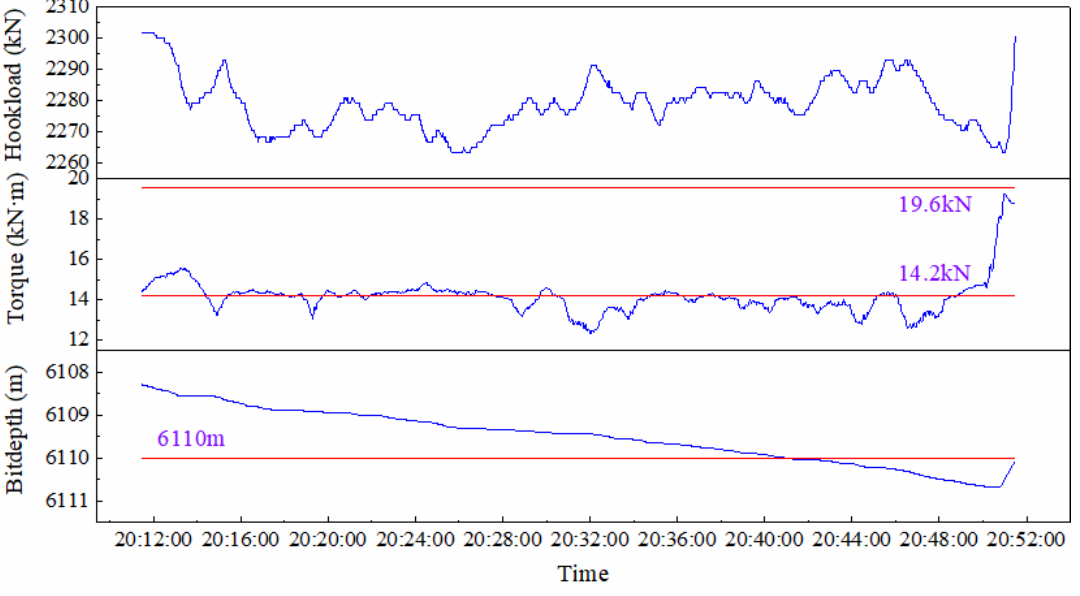
Figure 6. Hook tension and torque changes from 20:11:28 to 21:21:28.